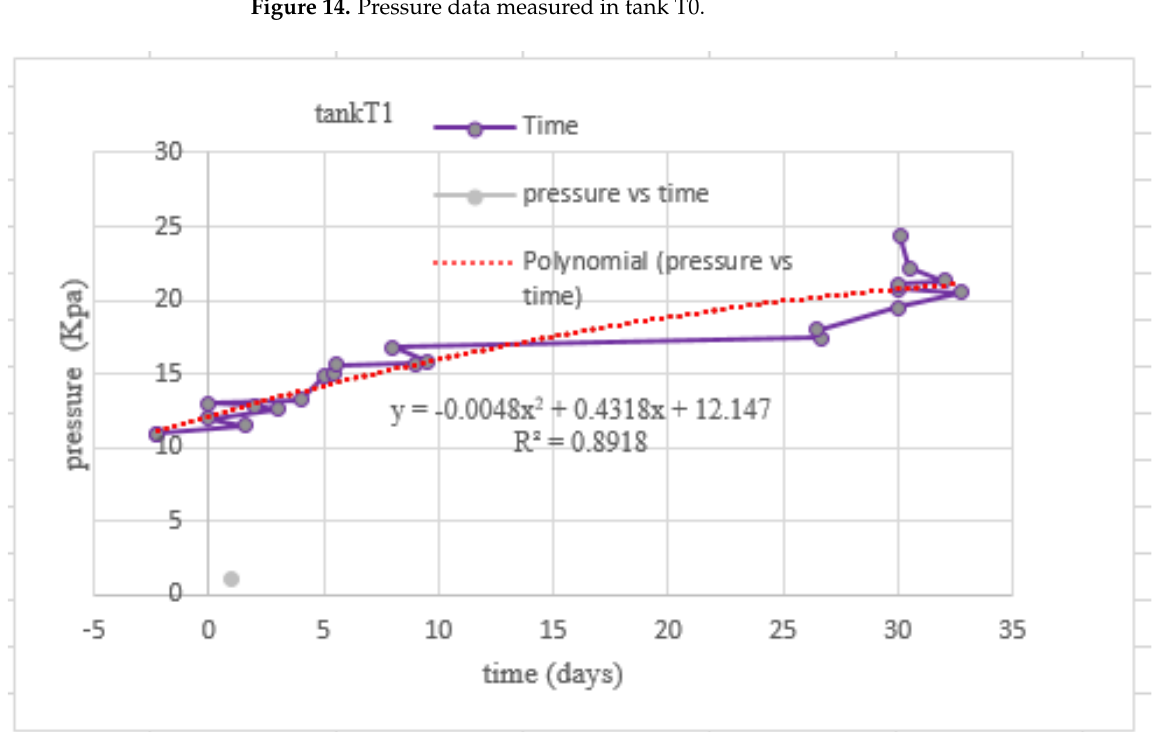
Figure 15. Pressure data measured in tank T1.